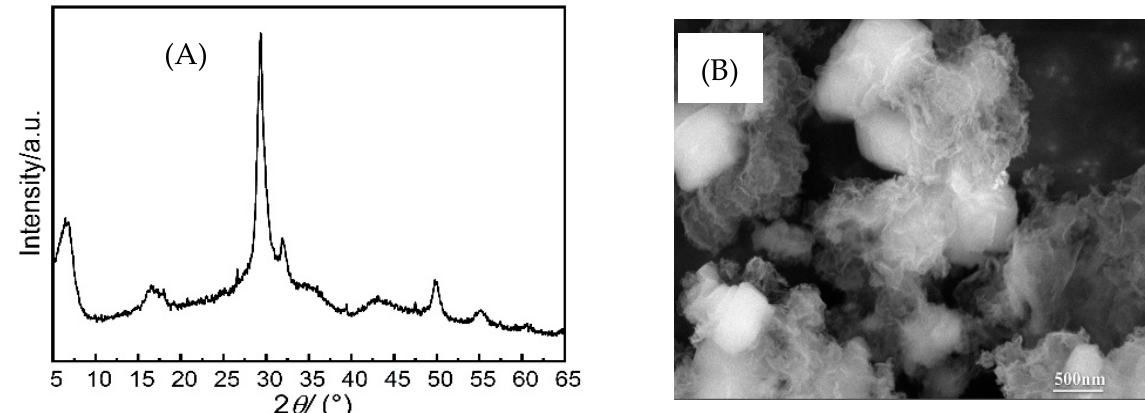
Figure 2. Properties of synthesized C-S-H seeds: ( A ) XRD pattern and ( B ) SEM picture.